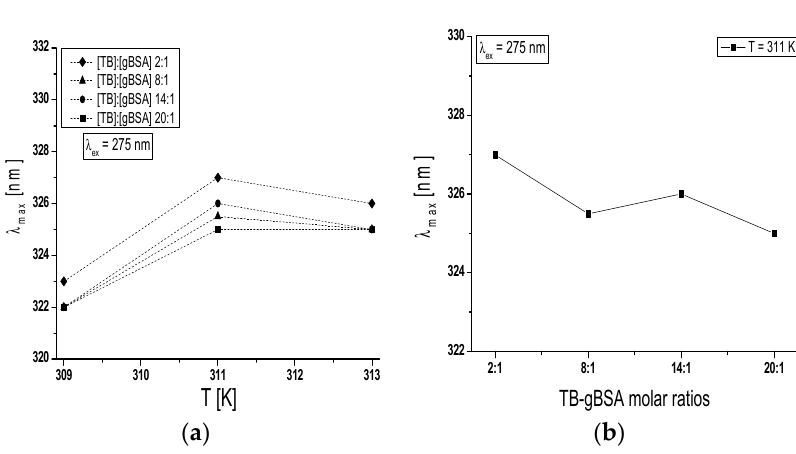
Figure 7. ( a ) Dependence of emission maximum wavelength ( λ max ) on temperature for TB-gBSA complex; and ( b ) dependence of λ max on TB-gBSA molar ratios for T = 311 K; TB:gBSA 2:1, 8:1, 14:1 and 20:1 molar ratios. The error bars are smaller than the symbols.